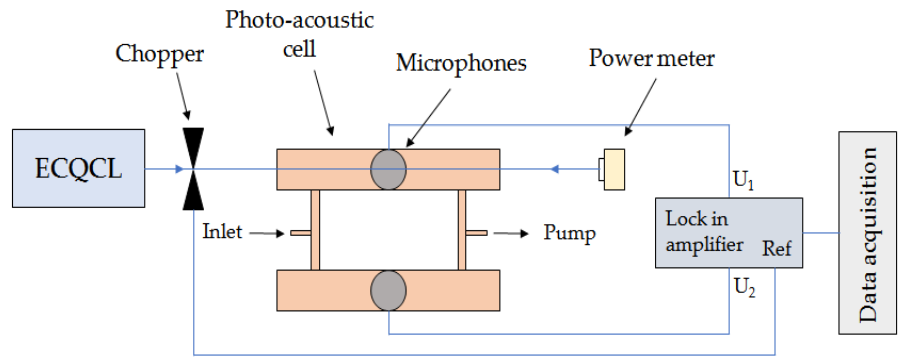
Figure 9. Structure diagram of spectral detection.